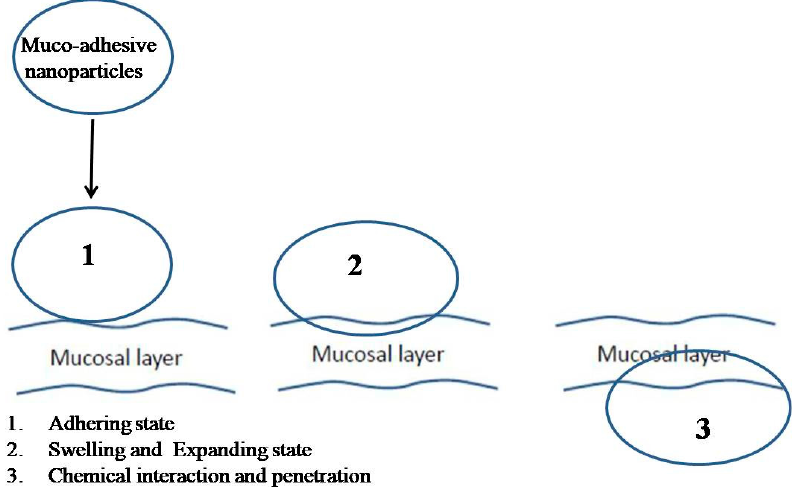
Figure 2. Scheme illustrating a possible penetration mechanism of synthetic mucoadhesive nanoparticles on mucosal